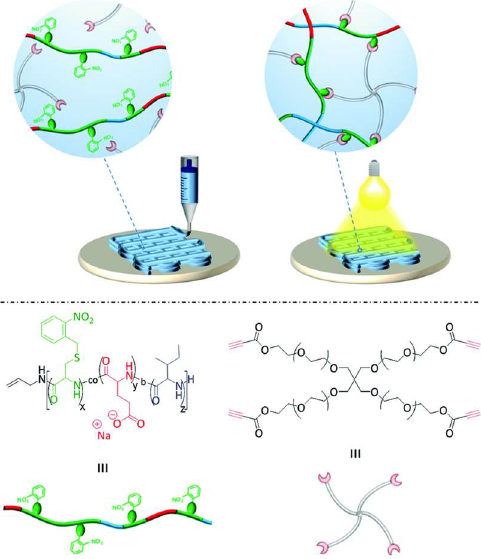
Figure 11. Schematic showing photocleavage of nitrobenzyl protecting groups revealing free thiol functionalities that react with peripheral propiolate functional groups on four-arm PEG. Reprinted with permission from [104].